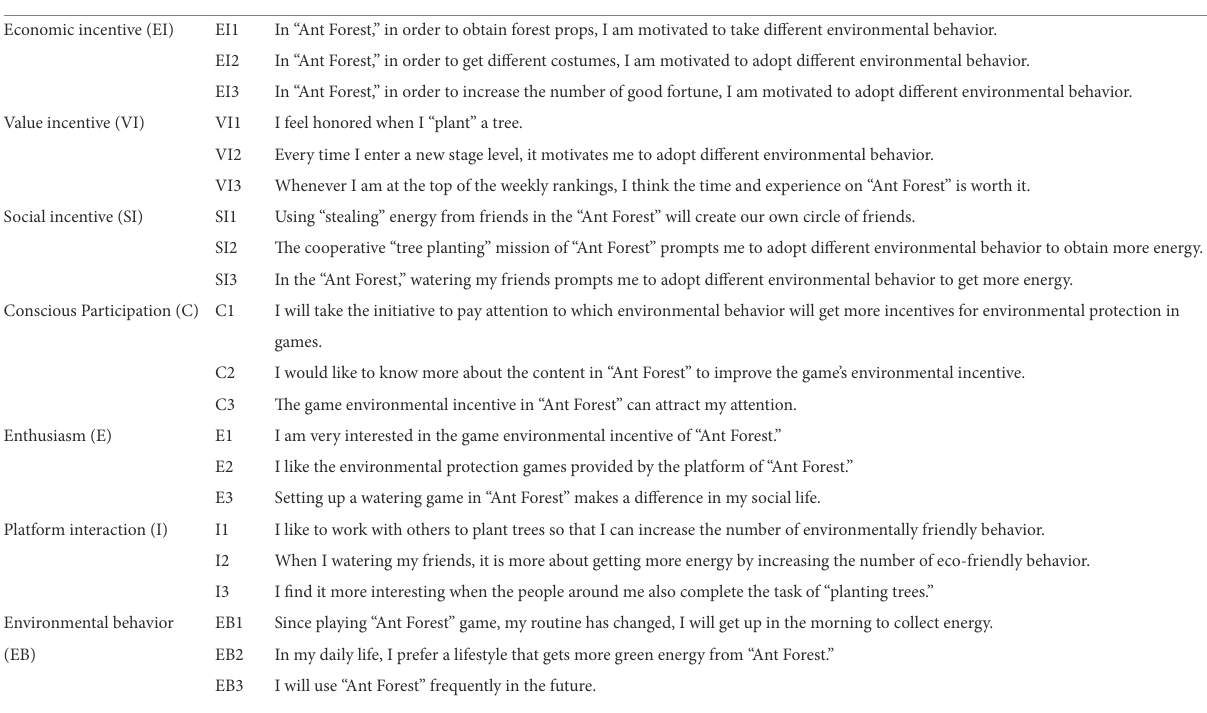
TABLE 2 Scales of the relevant